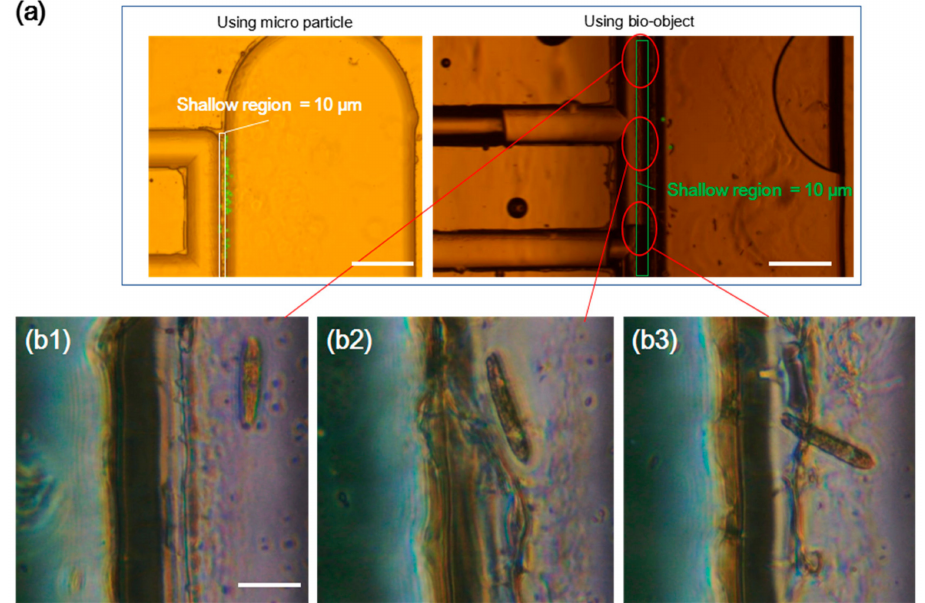
Figure 6. Demonstration results of the cell capturing device equipped with PDMS-membrane actuator. ( a ) Microparticles of 20- µ m diameter and Euglena captured in shallow gap structure. ( b1 – b3 ) Captured Euglena in the device. The scale bar is 100 µ